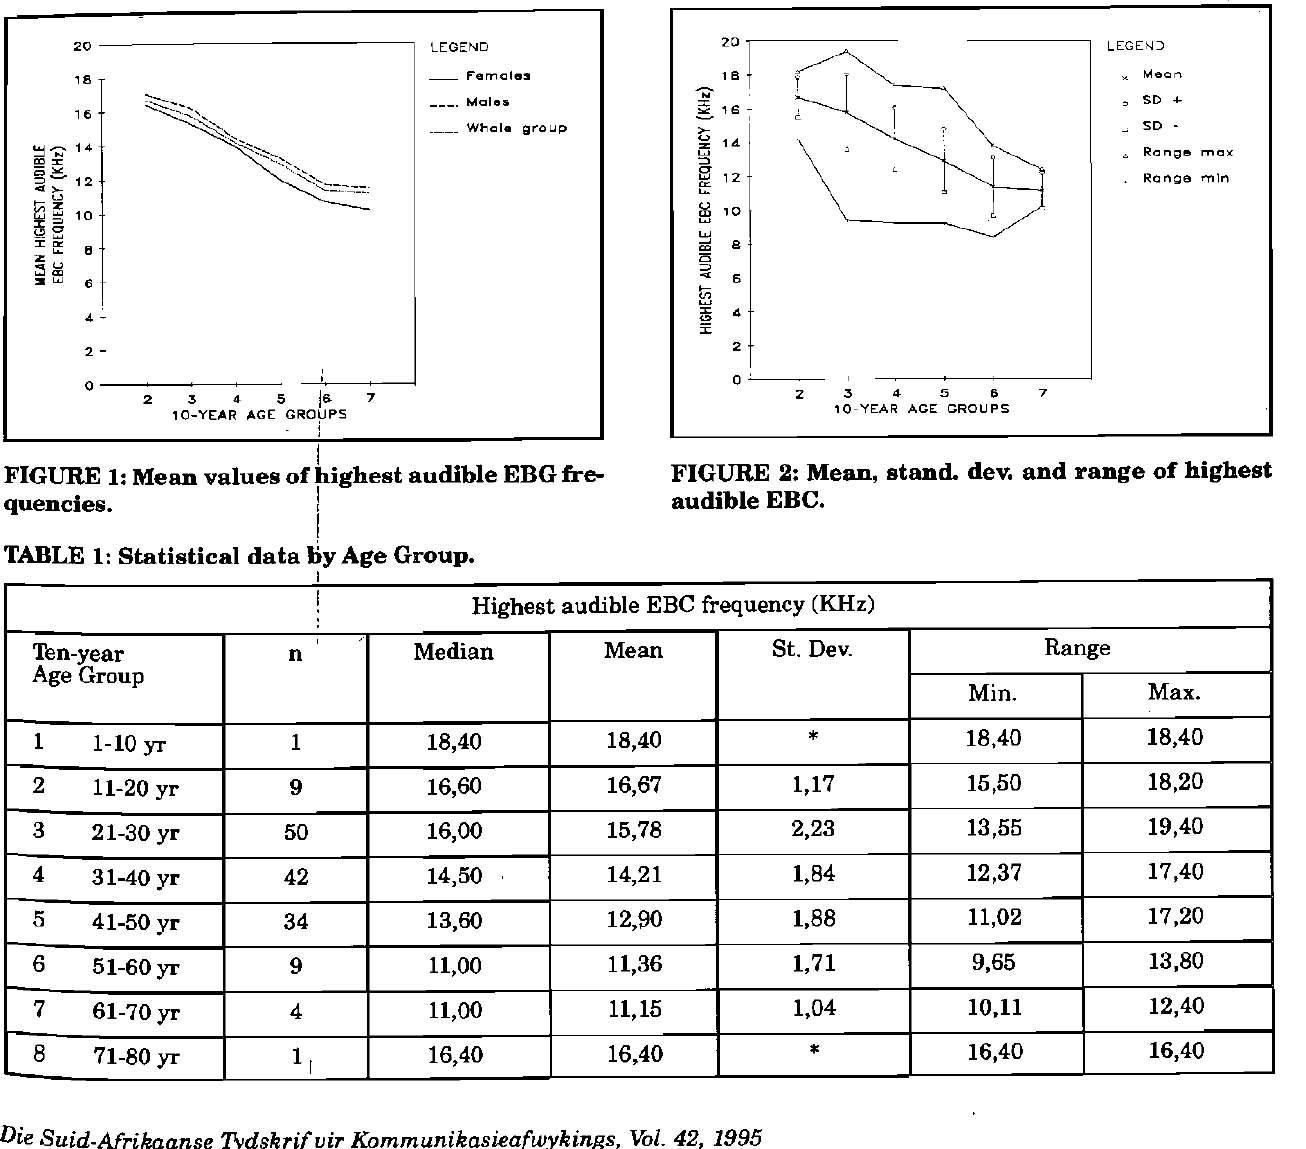
FIGURE 2: Mean, stand, dev. and range of highest audible